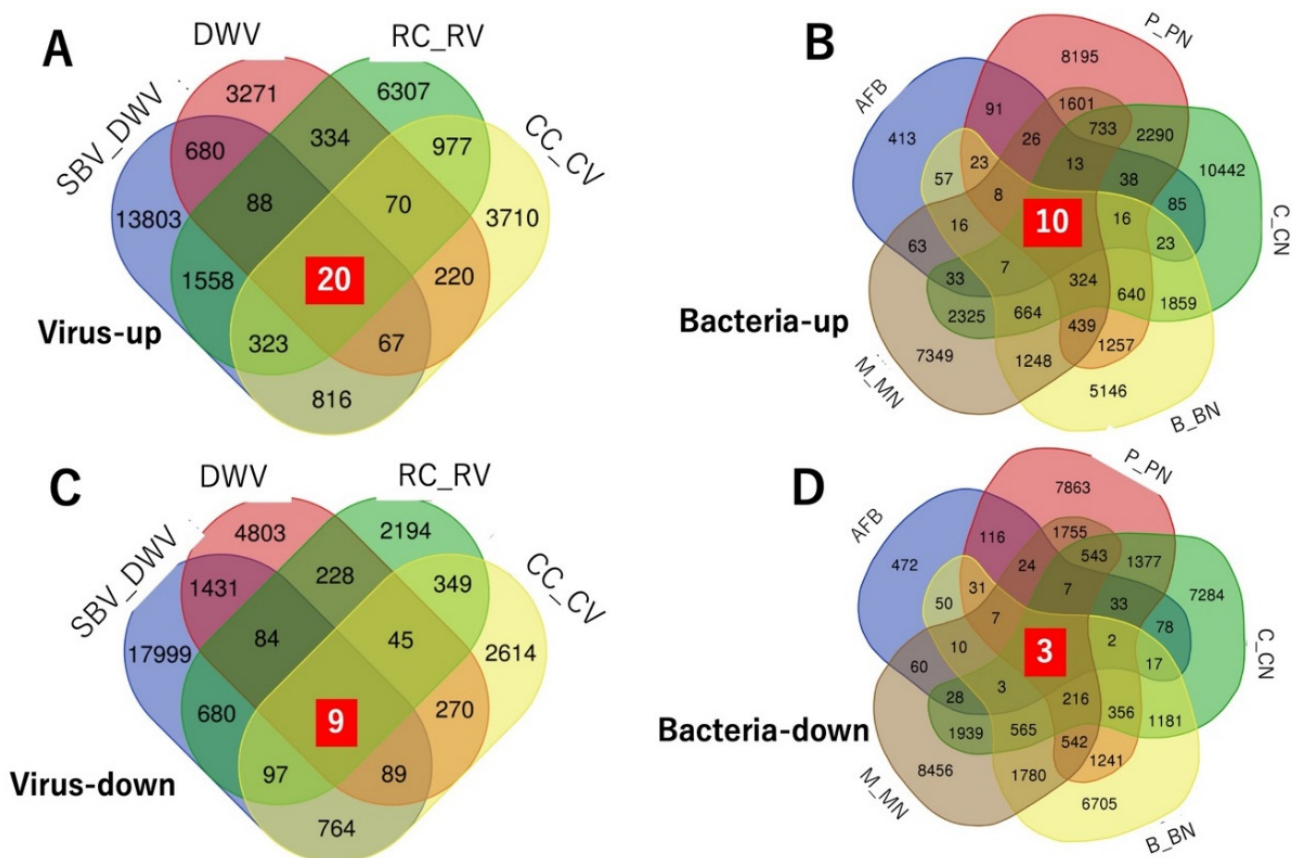
Figure 3. Transcripts upregulated or downregulated in response to viral or bacterial infection. Numbers in Venn diagrams indicate numbers of upregulated transcripts in experiments (Table 1) on viral infection ( A ) or bacterial infection ( B ) and numbers of downregulated transcripts in experiments on viral infection ( C ) or bacterial infection ( D ). White numbers in red squares indicate numbers of upregulated or downregulated transcripts in all experiments in ( A – D ).